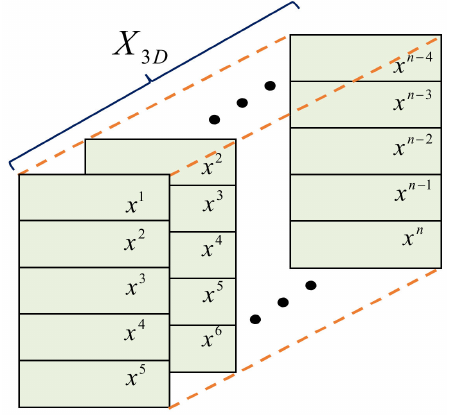
Figure 8. The 3D input